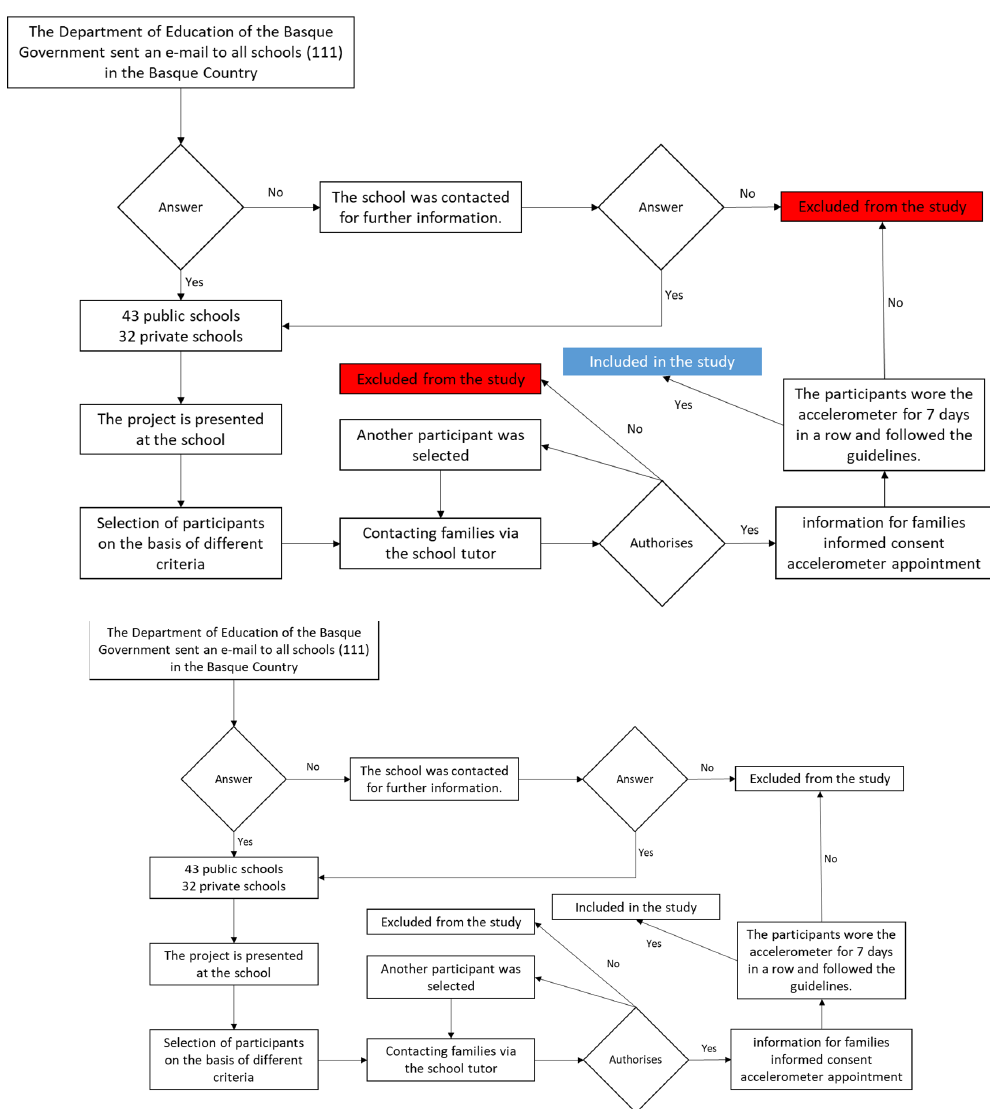
Figure 1. Participants reclusion flow chart.